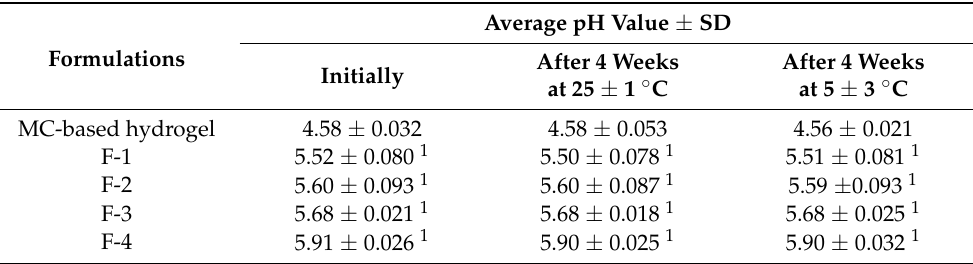
Table 7. Average pH values of the produced formulations — initially and after 4 weeks in different temperatures storage: at 25 ± 1 °C and at 5 ± 3 °C; n = 3.